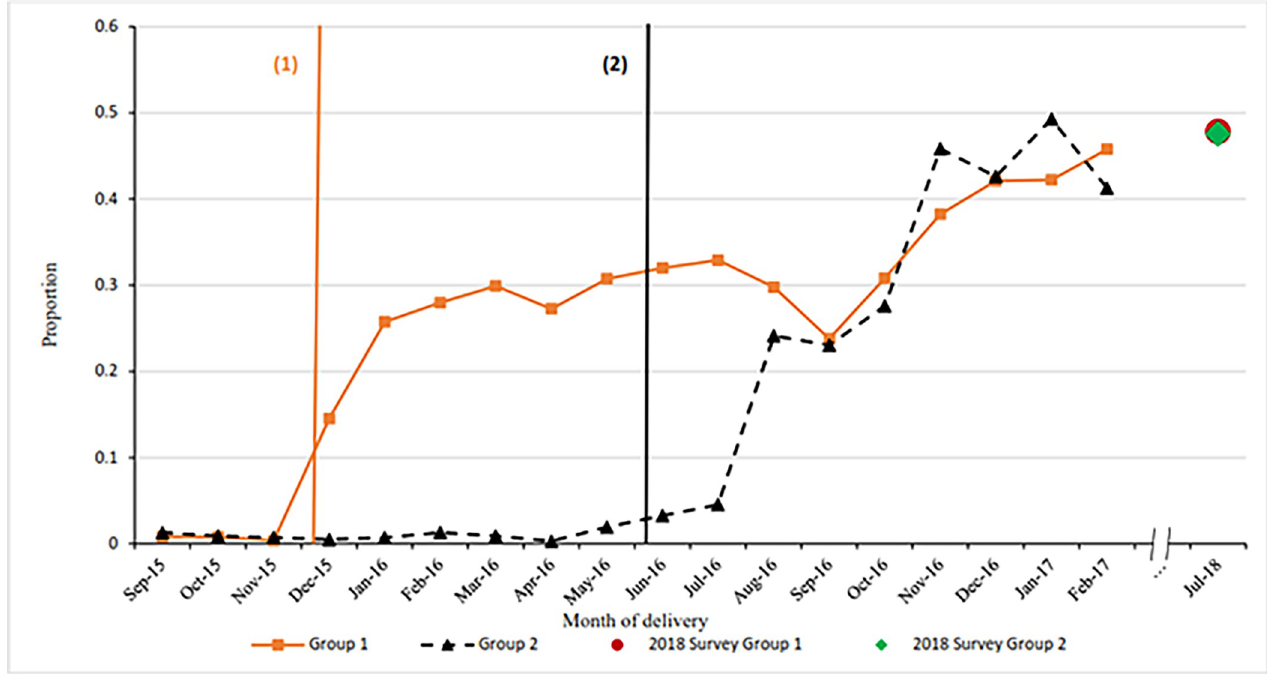
Fig 2. Proportion of women having PPIUD counselling classified by month of delivery in